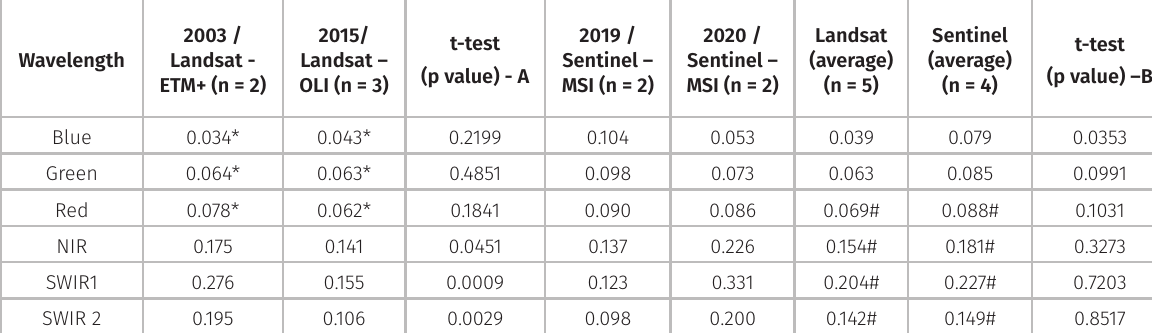
Table III. Lichens average surface reflectance values for Landsat and Sentinel-2, number of samples and result of the t-test between Landsat sensors (A) and between the averages of both satellites (B).